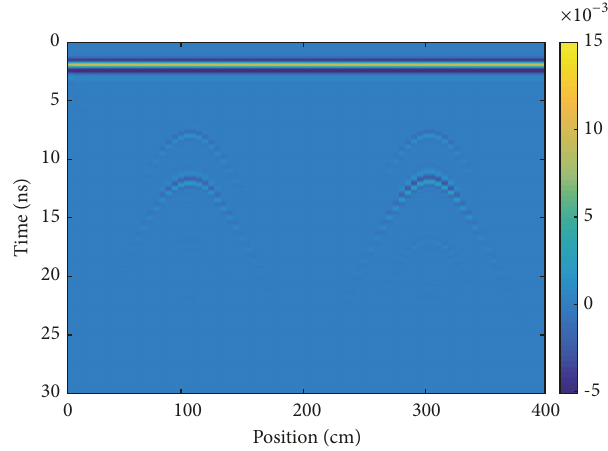
Figure 17: GPR simulation section with CUDA-implemented FDTD method.